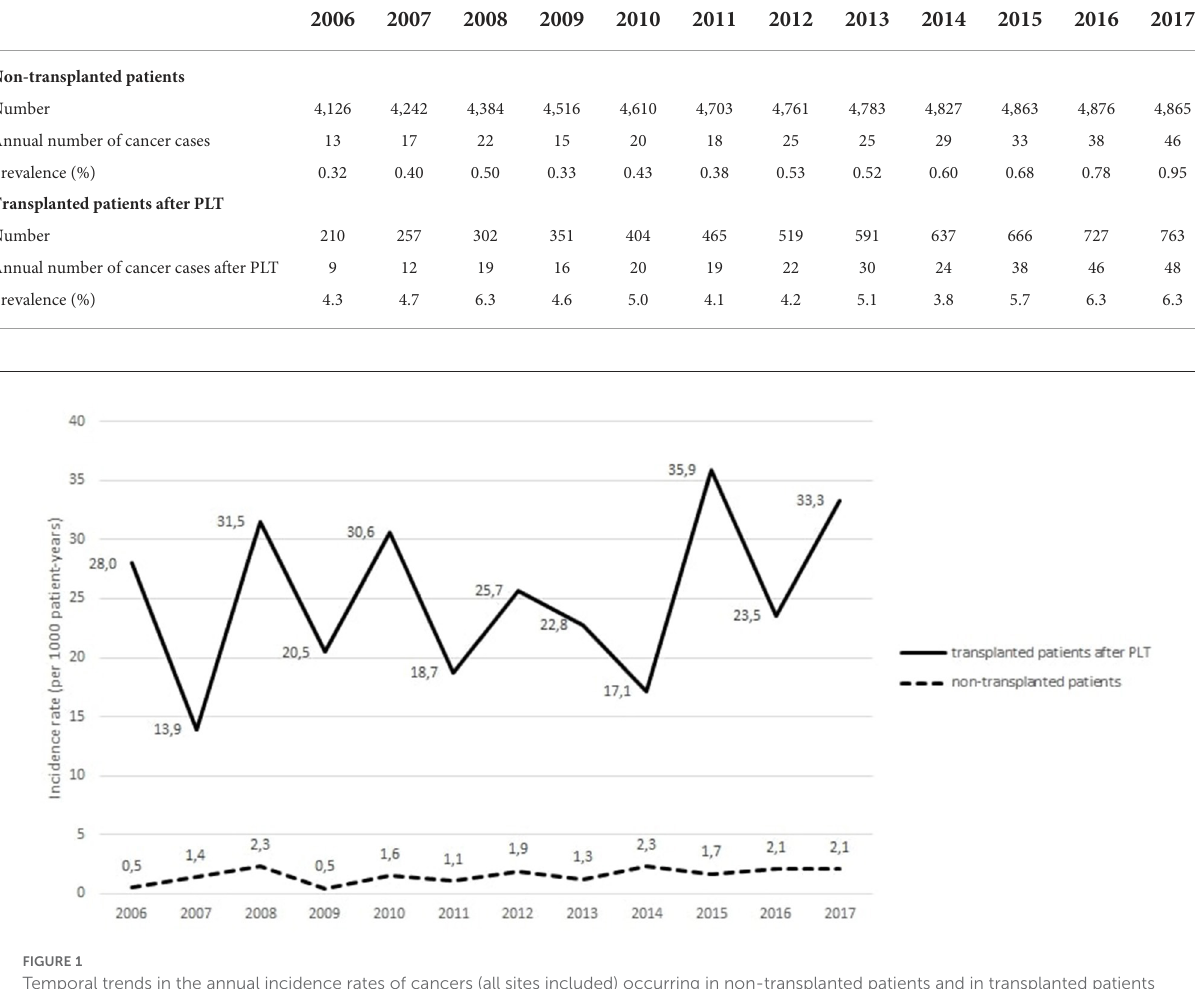
during the follow-up period (either before or after